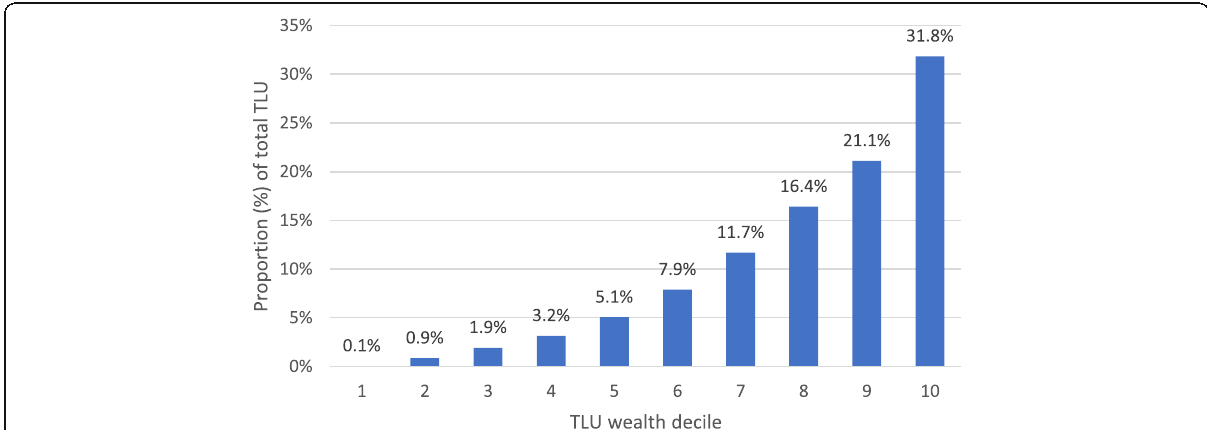
Fig. 1 Total livestock ownership by wealth decile, Karamoja a , 2017. Notes: n = 2729 households. a Data derived from the six districts of Amudat, Kaabong, Kotido, Napak, Nakapiripirit, and Moroto covered by the 2017 livestock demographic survey (Schloeder